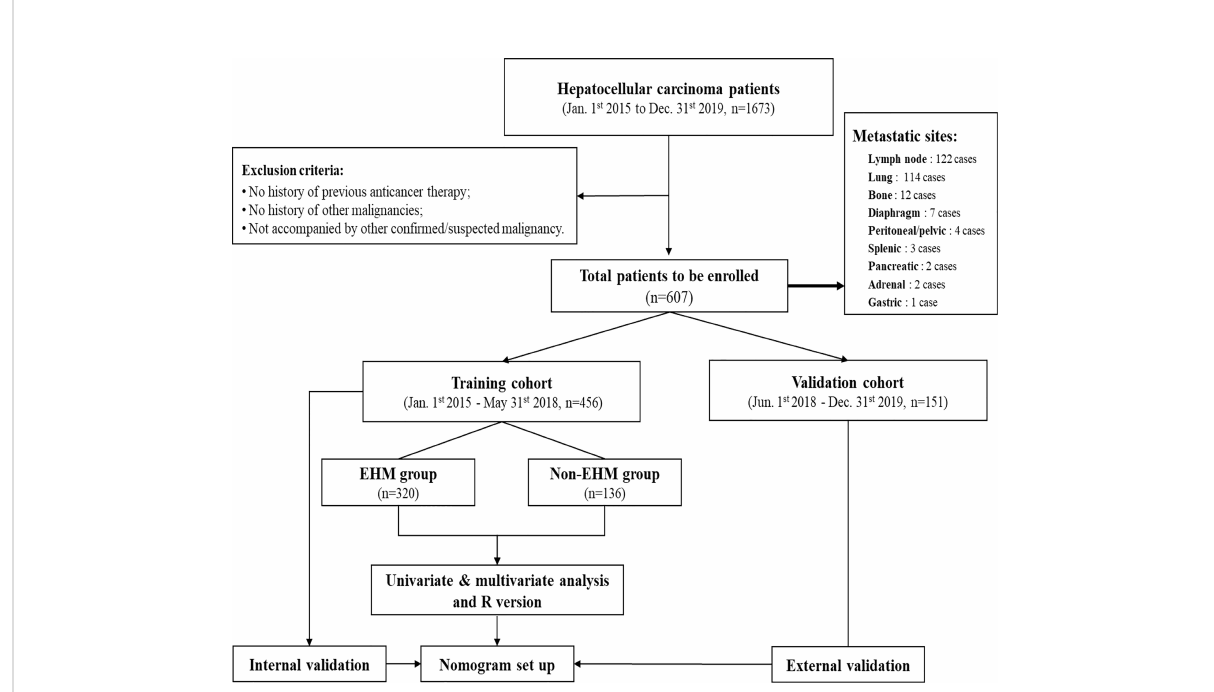
FIGURE 1 After the screening of medical records for the study, 607 cases were identi fi ed for fi nal enrolment based on exclusion criteria. The training cohort was used to identify factors that were able to predict EHM, thereby establishing a nomogram for this study. This nomogram was then validated regarding its accuracy in the evaluation of EHM risk by using both the training cohort and validation